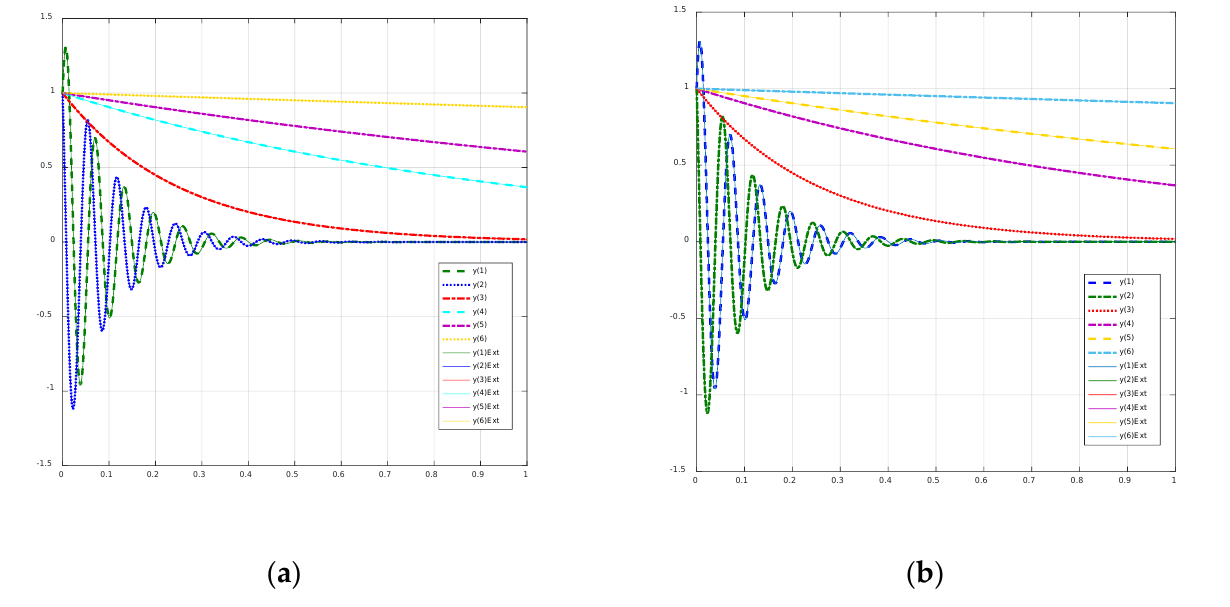
Figure 7. Graphical plots of Example 5 using block hybrid methods with nfe = 500. ( a ) Solution curve of Example 5 using method (18); ( b ) solution curve of Example 5 using method (21).